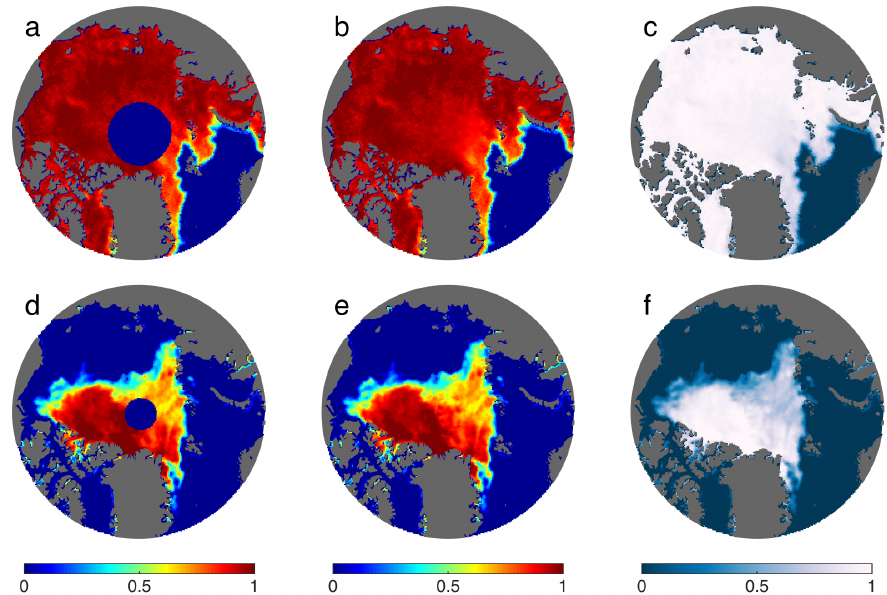
Figure 3. Examples of filling the polar data gap. For 6 January 1985: ( a ) sea ice concentration; ( b ) sea ice concentration with polar data gap filled using f (solution to Laplace’s equation plus a stochastic field Ω ); and ( c ) same as ( b ) but color scheme follows nsidc.org; ( d – f ) Same as ( a – c ), but for 30 August 2007.